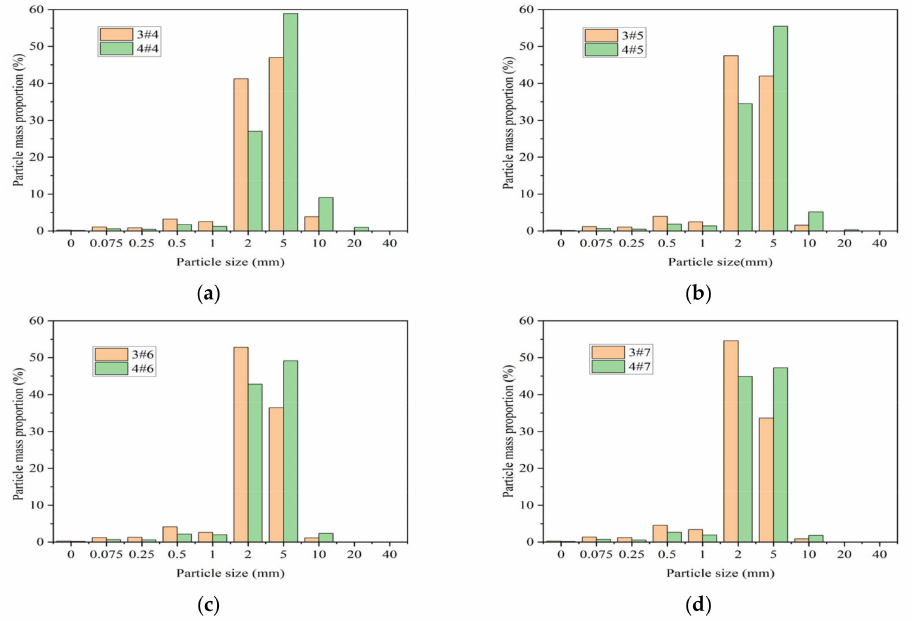
Figure 14. Comparison of particle content variation between freeze–thaw cycle of sample #3 and dry–wet cycle of sample #4: ( a ) the 4th cycle; ( b ) the 5th cycle; ( c ) the 6th cycle; ( d ) the 7th